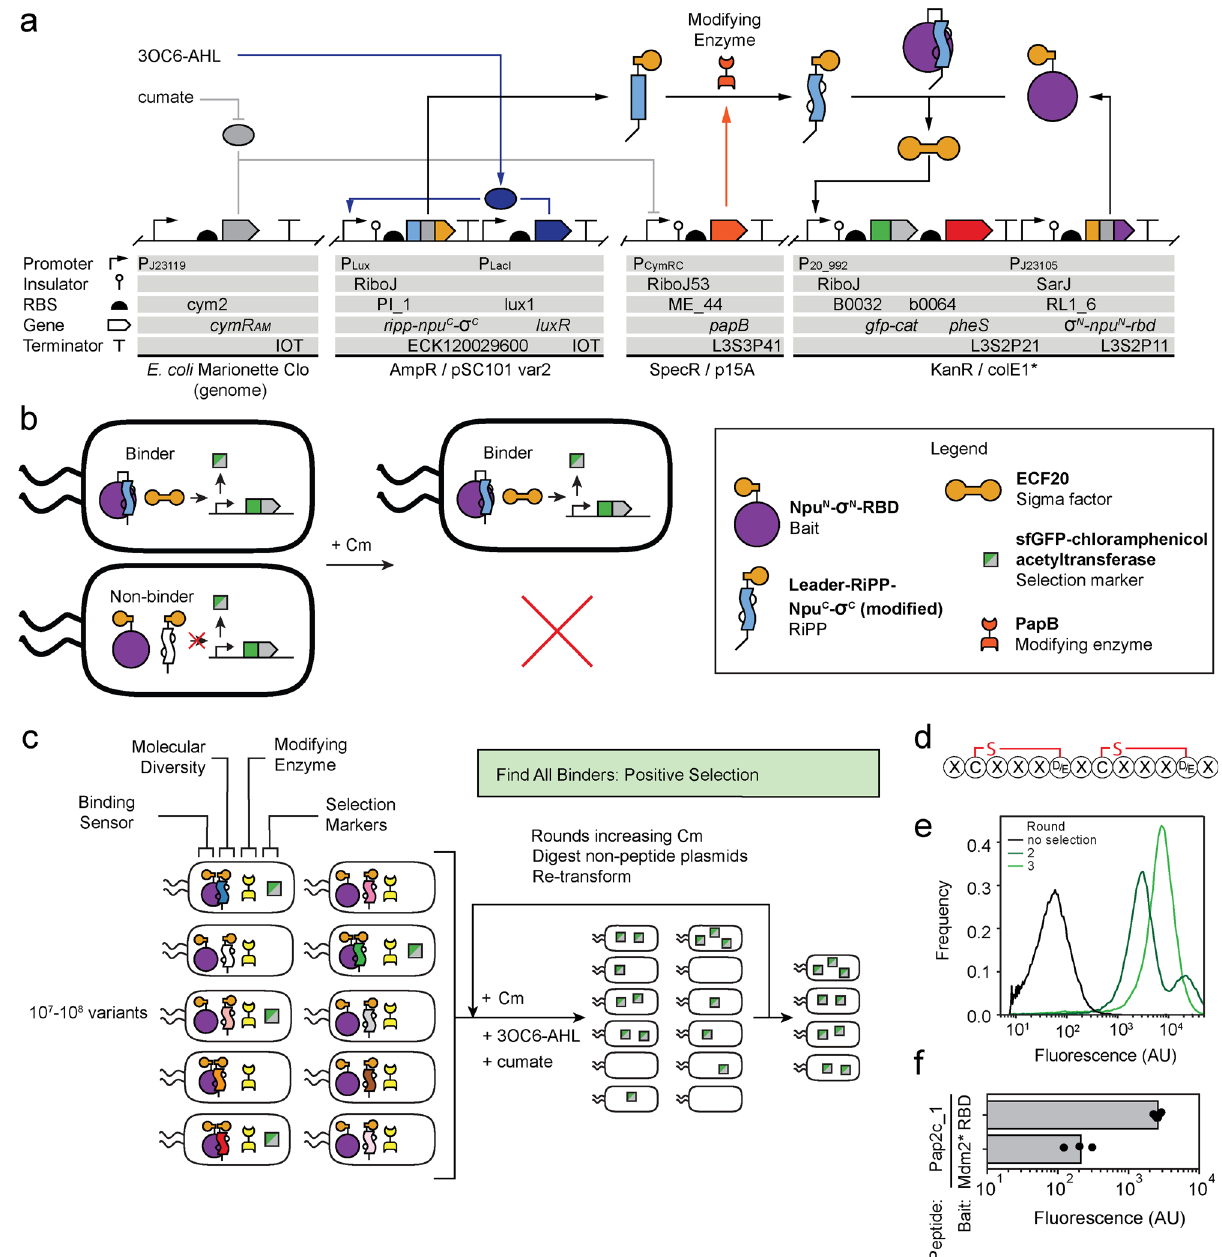
Fig. 2 Selection system to fi nd RBD-binding RiPPs. a The genetic circuit diagram for the RBD-binding RiPP selection system is distributed across three plasmids and two genomic regions. Two small molecules: 3OC6-AHL and cumate are used to control the expression of the RiPP peptide and modifying enzyme, respectively. b Schematic of selection output under two conditions: with an RBD-binding RiPP and without an RBD-binding RiPP. Binding is shown to result in the production of GFP-chloramphenicol acetyltransferase (GFP-CAT; green/gray squares). c Overview of the positive selection. Selection rounds were conducted in the presence of the RiPP peptide and modifying enzymes and used increasing Cm concentrations for increased stringency. d The core scaffold for the Pap2c library (lbAMK-103). Predicted macrocyles are colored between constrained residues and “ X ” residues correspond to NNK translated amino acids. e Cytometry distributions for positive selections on the Pap2c library beginning with no selection, round 2, and round 3 of positive selections (0, 800, and 1200 μ M Cm). Fluorescence of the GFP fused to CAT is reported. f RBD-speci fi c hit (Pap2c_1) isolated from genetic selection. Pap2c_1 was used as peptide against the non-speci fi c bait (Mdm2*) and speci fi c bait (RBD). 3OC6-AHL (1 μ M) was used for inductions and three replicates performed on different days are